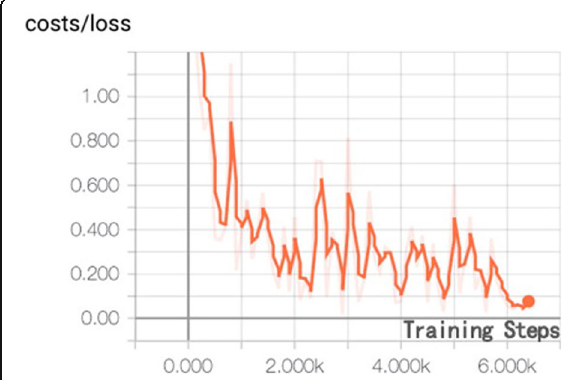
Fig. 5 Loss function curves of simulation model construction process on intercropping corn and potato